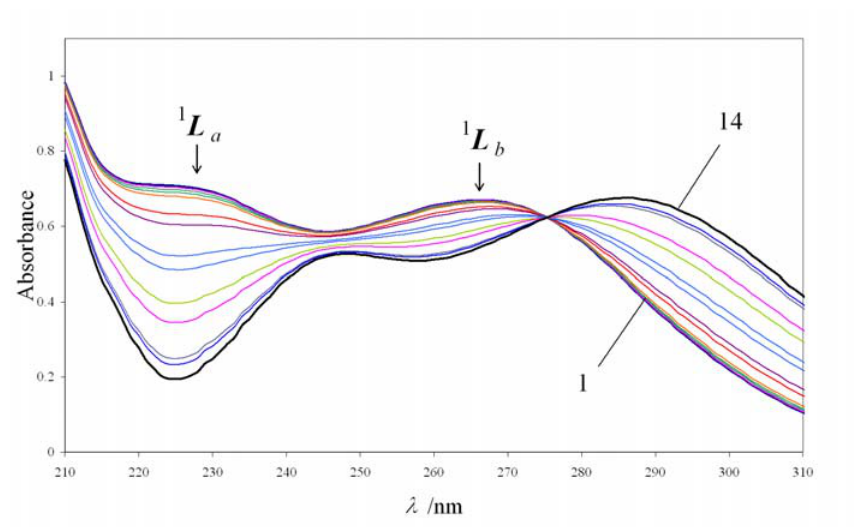
Fig. 4 Reconstructed absorption spectra of p -benzotoluidide as a function of sulfuric acid concentration from 0.5 (curve 1) to 15.0 mol dm − 3 (curve 14). and McClelland